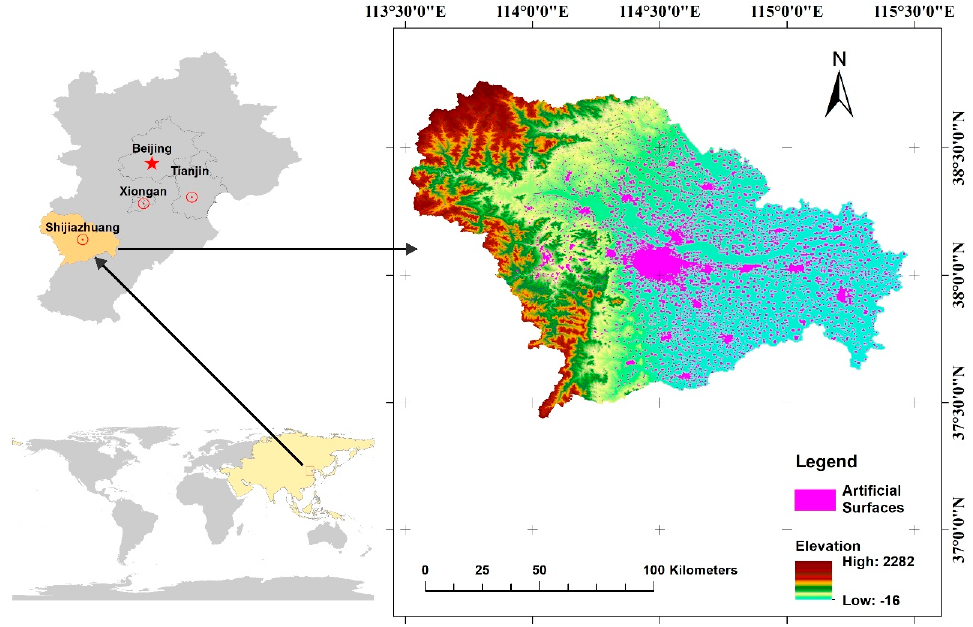
Figure 1. Geographical location, topography, and artificial surfaces of Shijiazhuang.